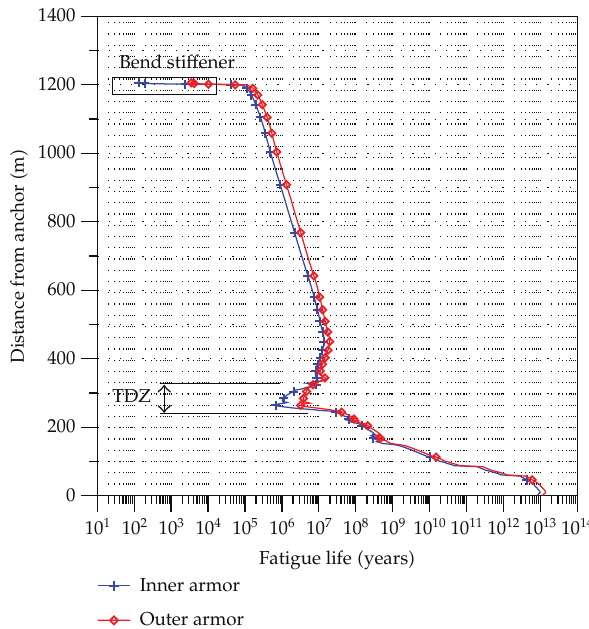
Figure 7: Fatigue life along the flexible pipe: base case.